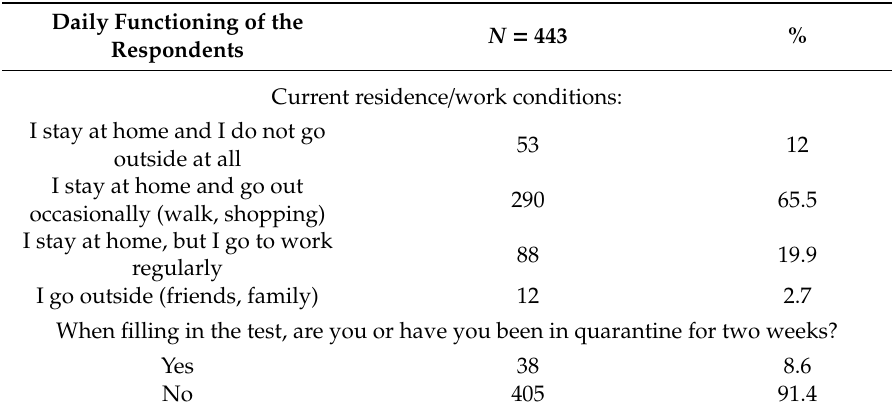
Table 2. Daily functioning of the respondents during the pandemic ( N =